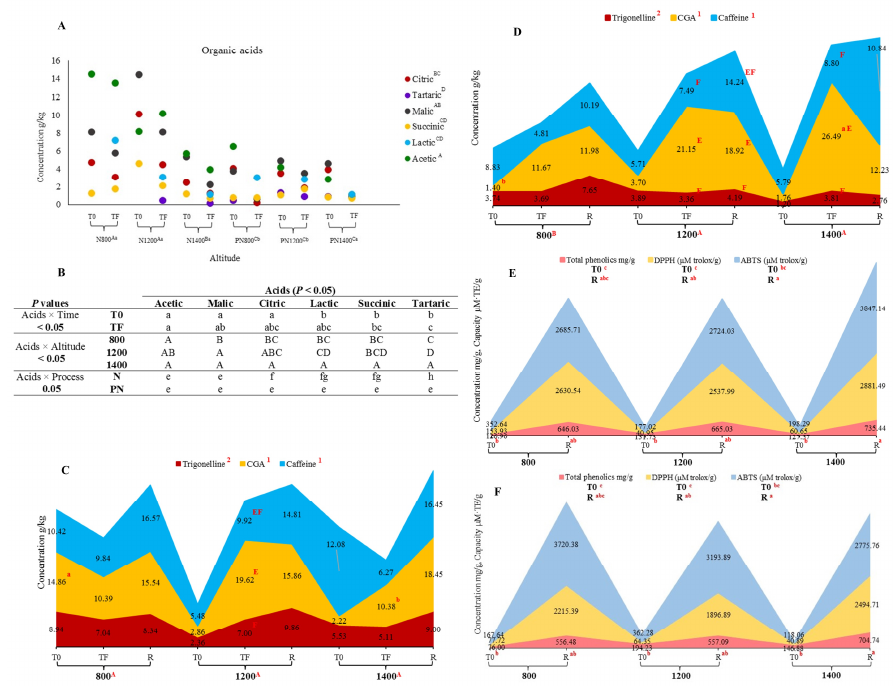
Figure 3 Figure 2. ( A ) Organic acid concentrations detected before fermentation and after drying from coffees proceeded via natural and pulped natural at different altitudes (800, 1200, and 1400 m). N = natural process, and PN = pulped natural process. T0 = before fermentation, and TF = after drying. Different uppercase letters in the altitudes represent statistical differences at p < 0.05 in each process: A, B = N, and C = PN. Different lowercase letters in the altitudes represent statistical differences at p < 0.05 between the processes for each altitude: a,b . Different uppercase letters on the acids represent statistical differences between them at p < 0.05: A, AB, BC, CD, D, D . Standard deviations: 800 (N: 0–5.67 and PN: 0–4.33), 1200 (N: 0–3.03 and PN: 0–3.83), and 1400 m (N: 0.06–1.38 and PN: